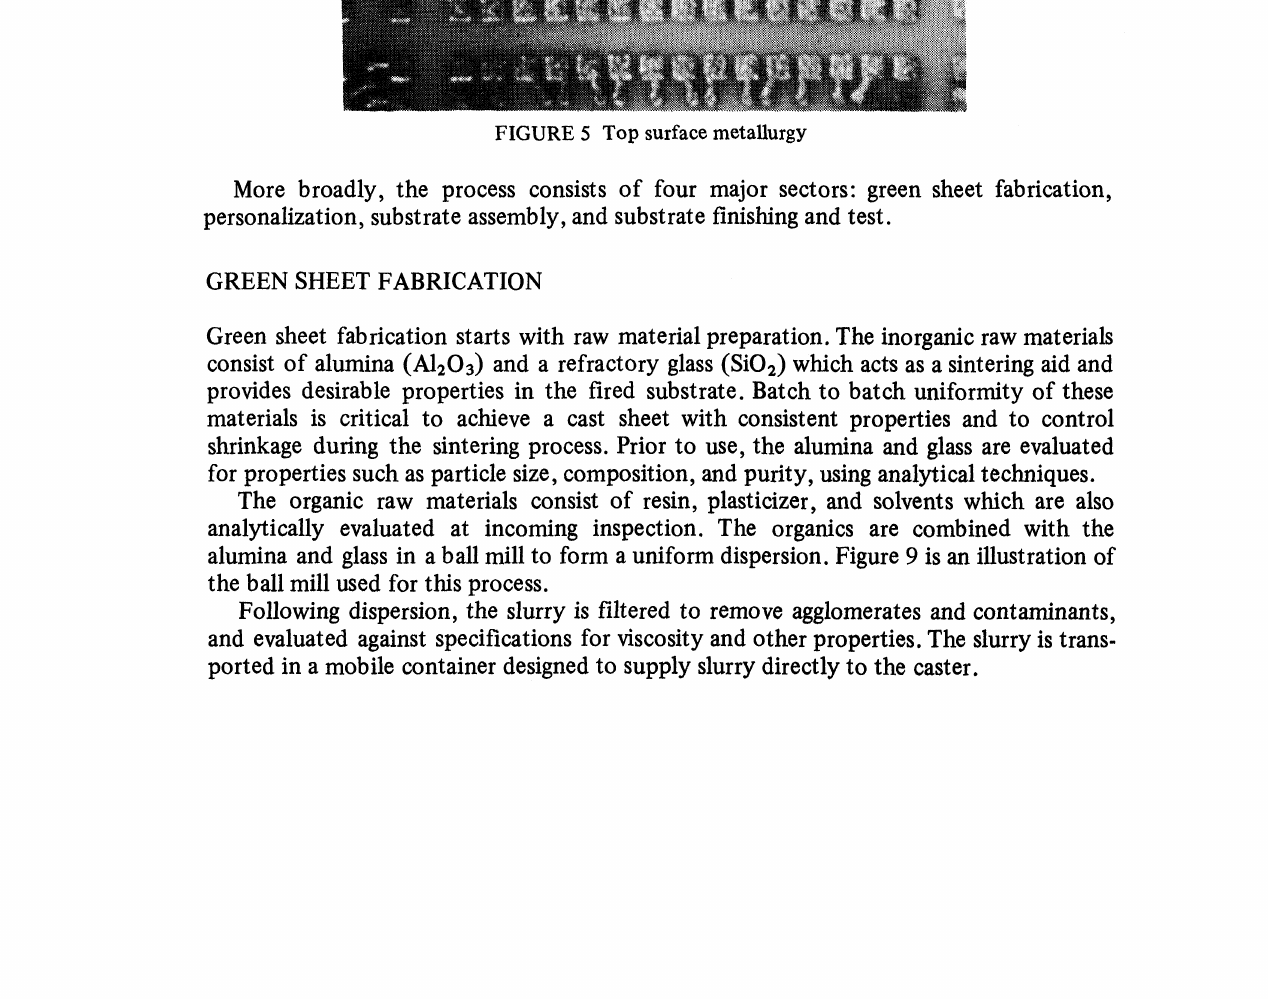
FIGURE 5 Top surface